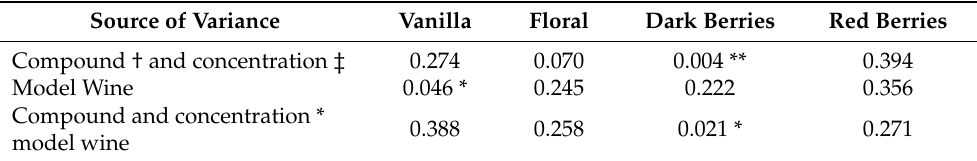
Table 3. p -values for ANOVA Type 1 sum of squares analysis for each aroma attribute. Source of Variance Vanilla Floral Dark Berries Red Berries Compound † and concentration ‡ 0.274 0.070 Model Wine 0.046 *